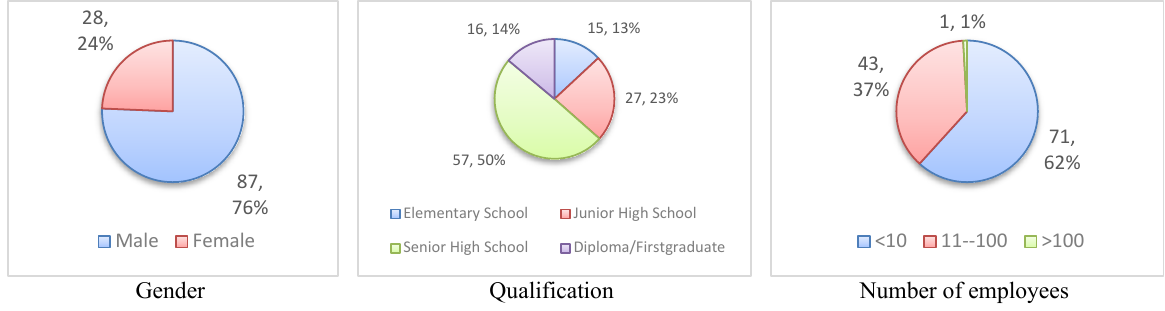
Fig. 1. Respondents’